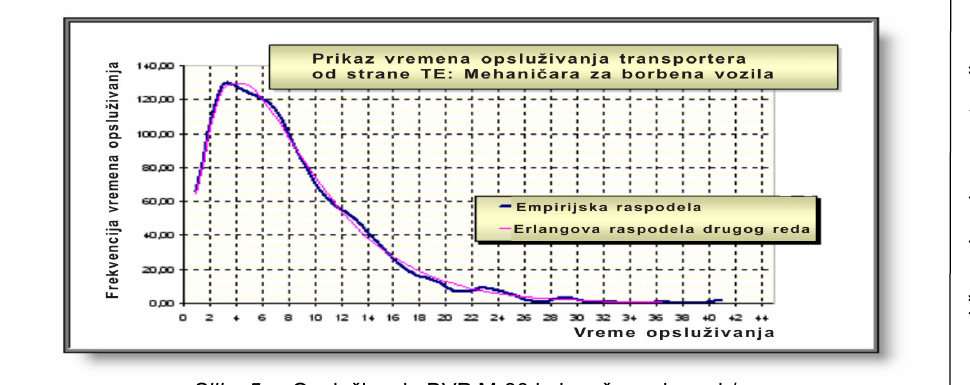
Figure 5 – M-80 served by mechanics for c/v